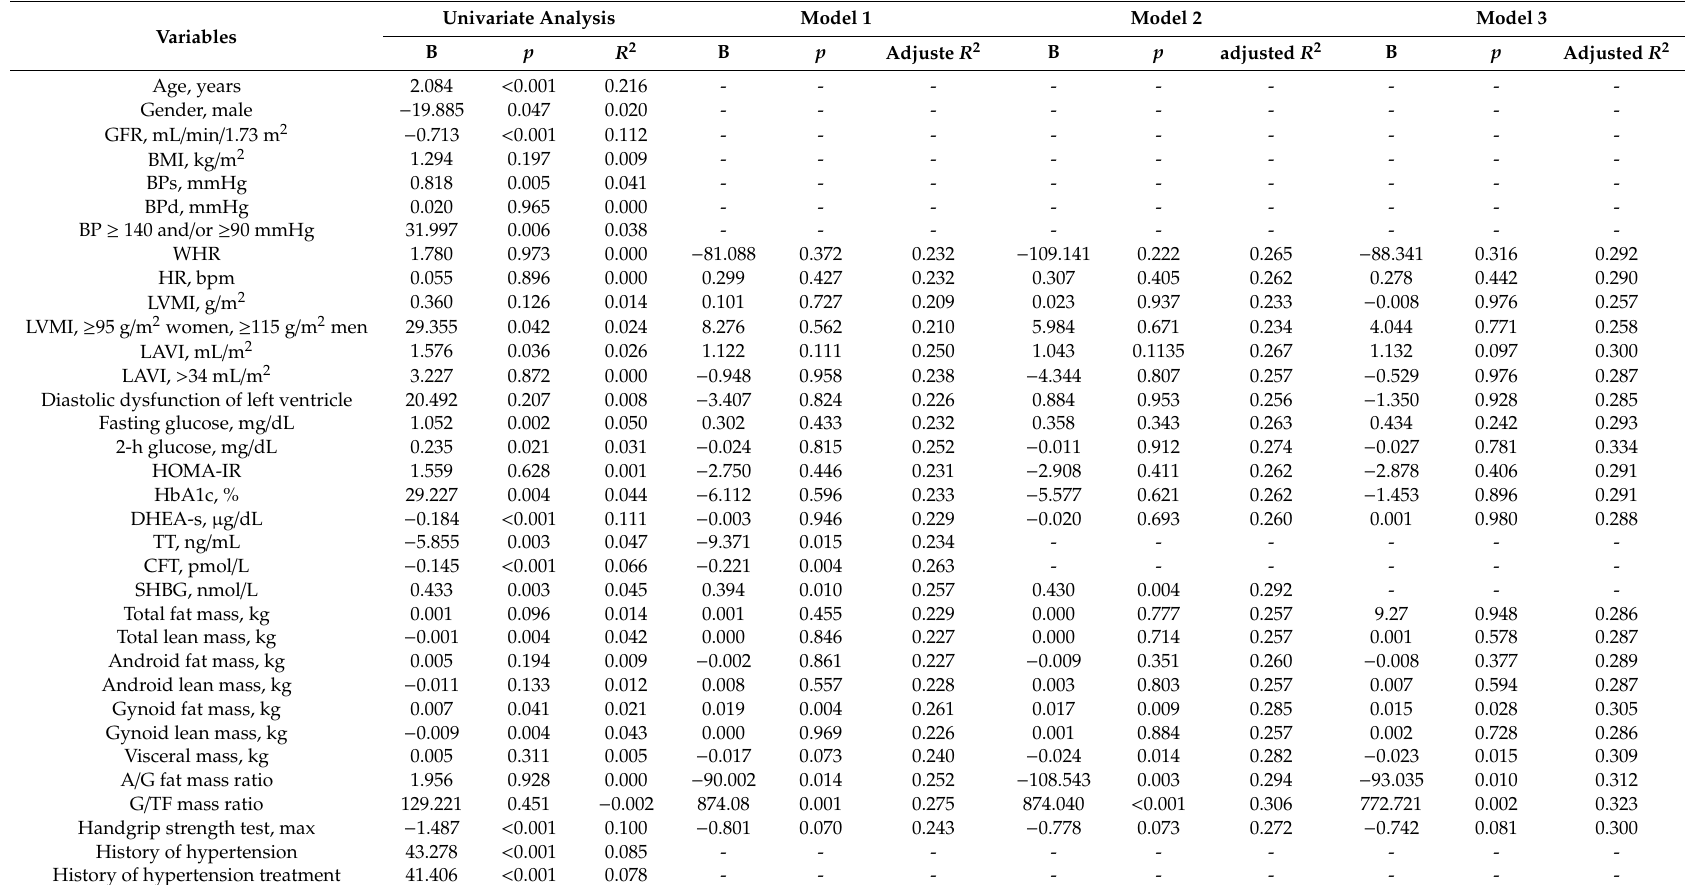
Table 3. Results of NT-proBNP analysis in the general